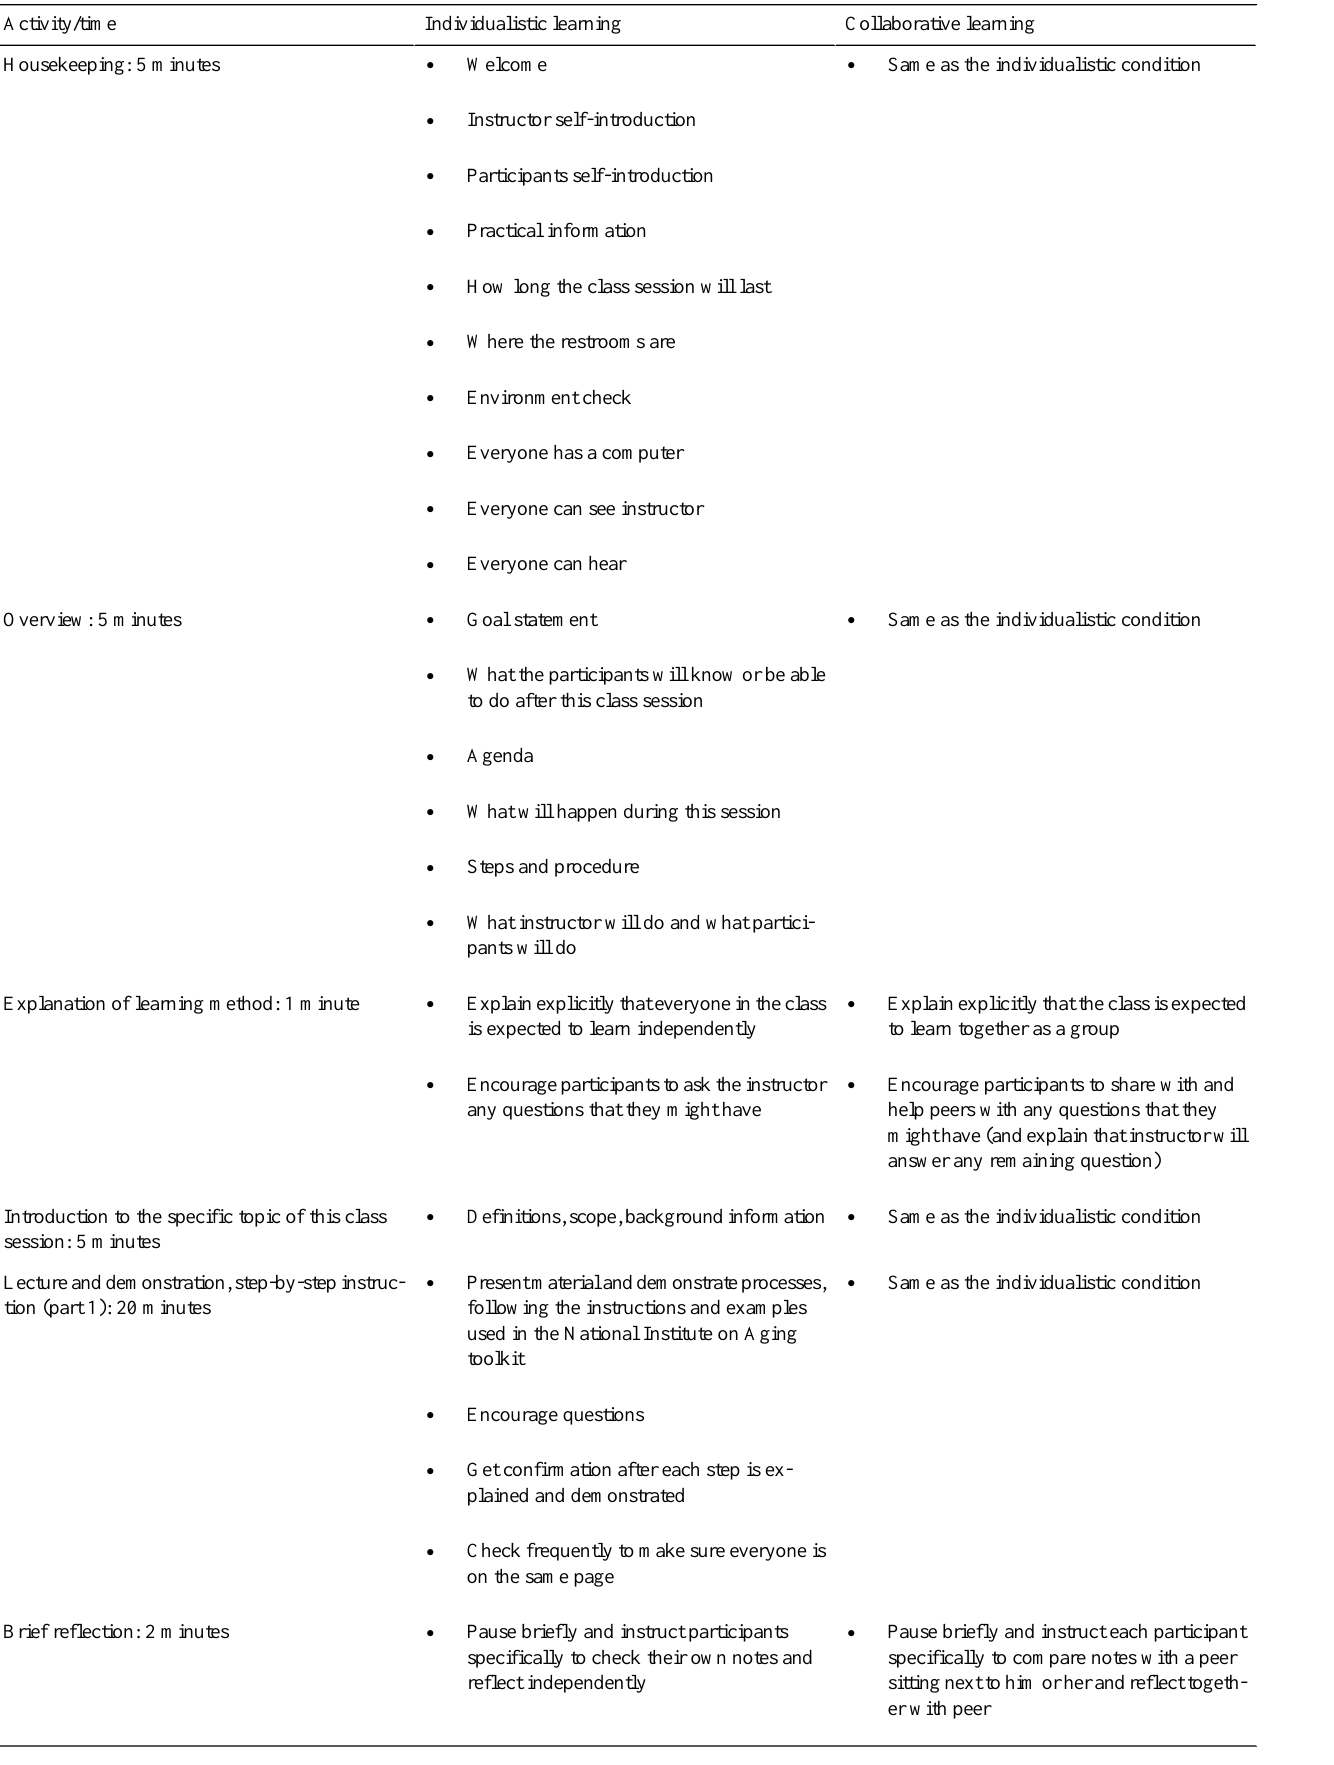
Table 4. Class structure and strategies for the learning conditions